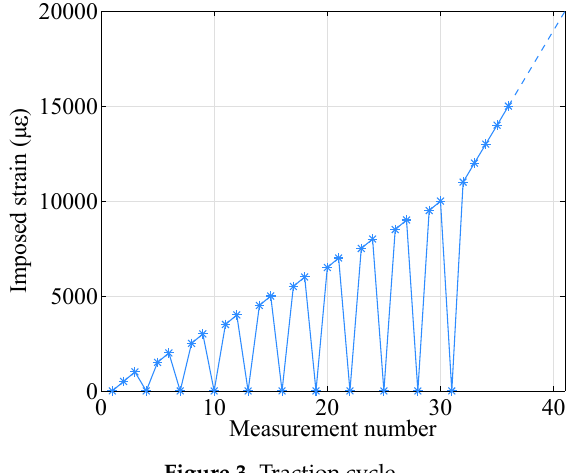
Figure 3. Traction